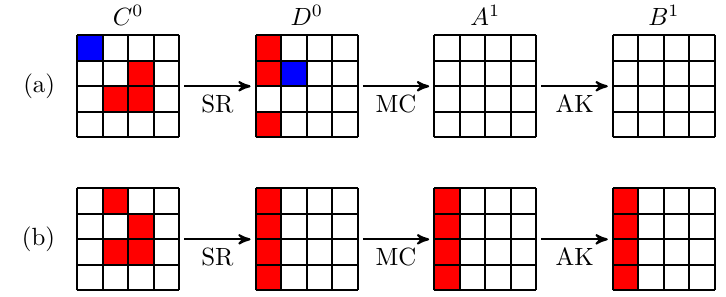
Figure 3: Illustration of the two propagations cases with four fixed